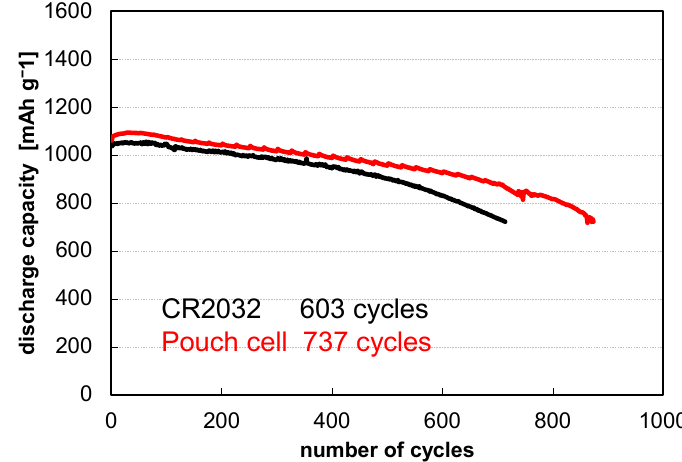
Figure 10. Cycling behavior of full cells (discharge capacity of anode active material) based on pre- lithiated anodes with carbon coated, classified CLM00001 in different cell formats. This combination allows more than 600 cycles at 80% capacity retention in the 4.2–3.0 V window.